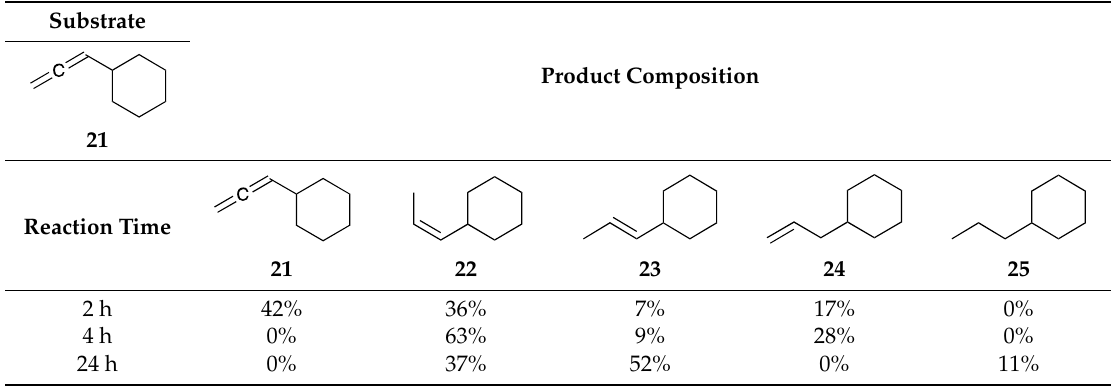
Table 3. Kinetic study of the catalytic reaction of 1-cyclohexylpropa-1,2-diene 21 a .